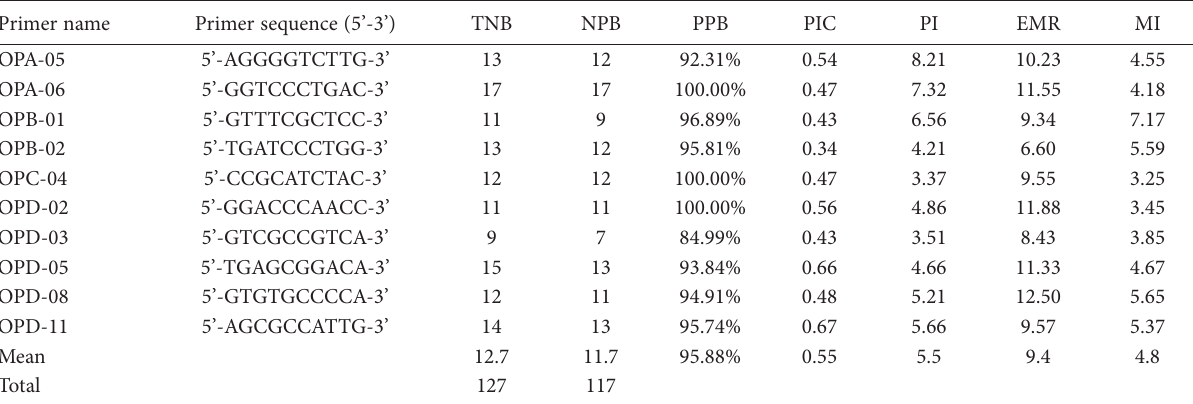
Table 2. RAPD primers and other parameters. Note: TNB - the number of total bands, NPB: the number of polymorphic bands, PPB (%): the percentage of polymorphic bands, PI: polymorphism index, EMR, effective multiplex ratio; MI, marker index; PIC, polymorphism information content for each of CBDP